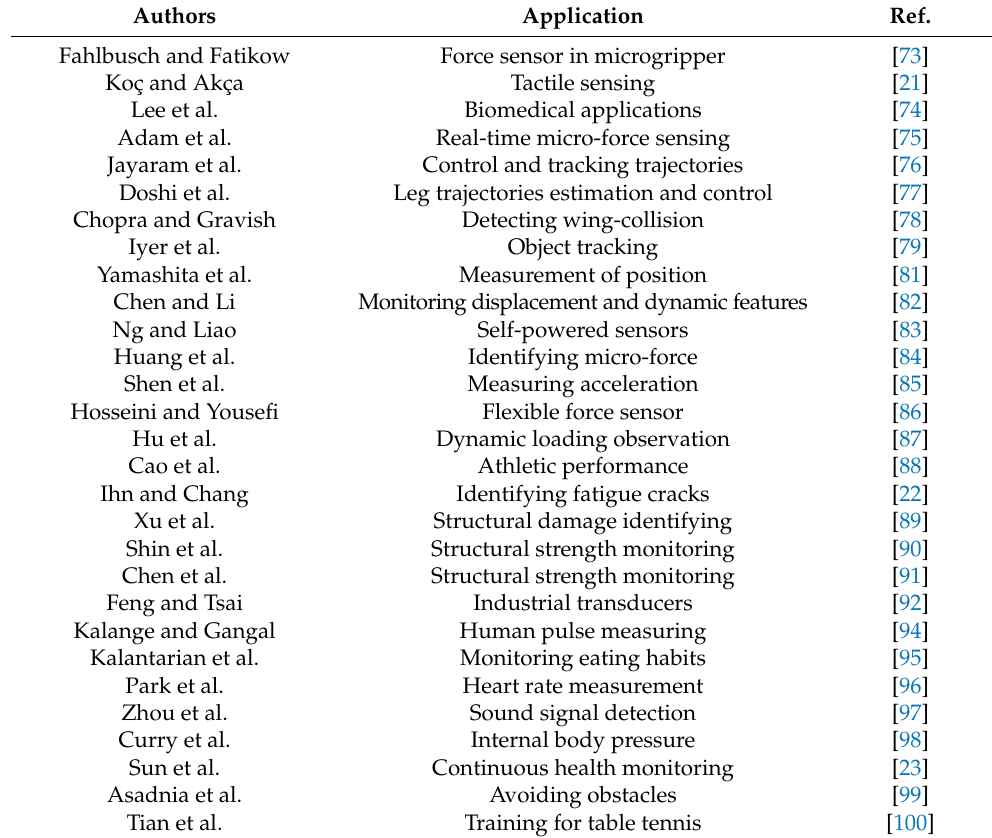
Training for table tennis